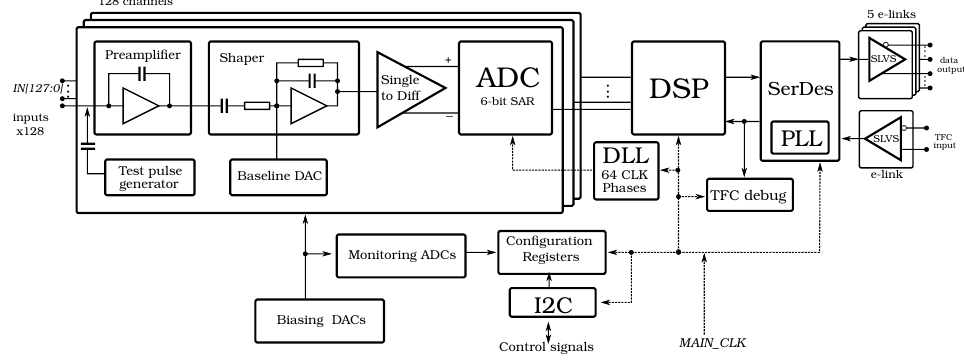
Figure 1. The SALT ASIC block